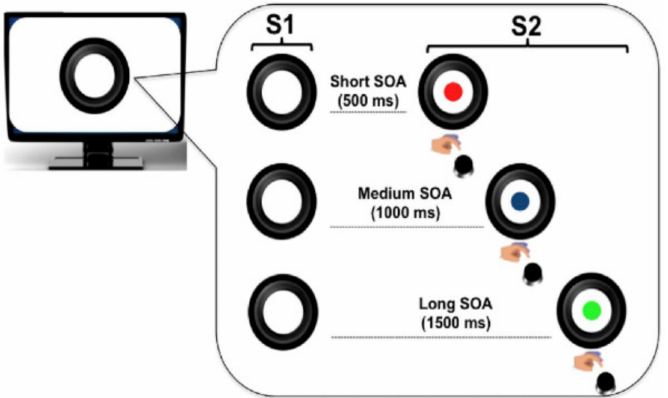
Figure 1. Trial structure. The circle (S1) warned participants on the presentation of the imperative S2 stimulus (a cartoon character; here represented with colored disks for illustrative purposes due to copyright restriction). Participants had to make speeded reaction times at S2 onset by pressing a button on the keyboard. The effect of local prediction was assessed by manipulating S1–S2 stimulus onset asynchrony (SOA) within each experimental block.